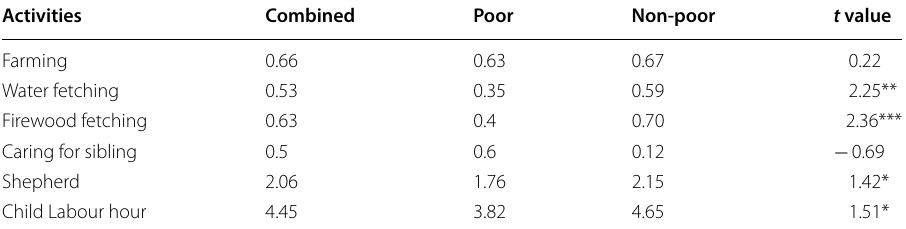
***, ** and * 1%, 5% and 10% level of significance,